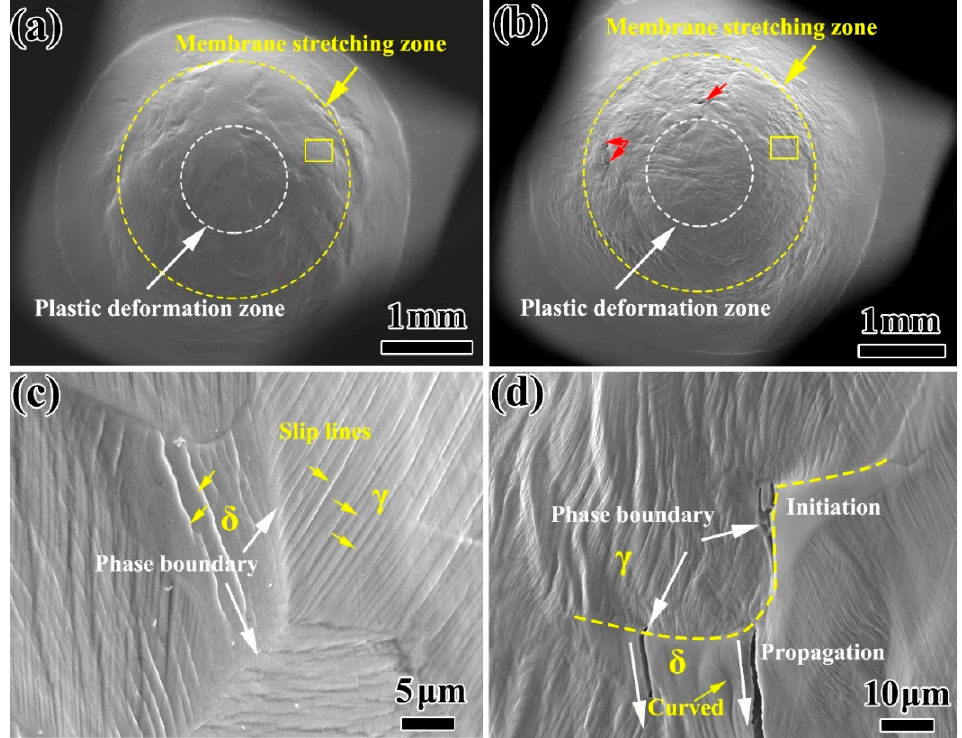
Figure 7. The overall SEM morphology of the small punch specimen after thermal aging for 0 h ( a ) and 10,000 h ( b ) at the same displacement; ( c , d ) are the SEM morphology of the corresponding position in the yellow box ( a , b ).